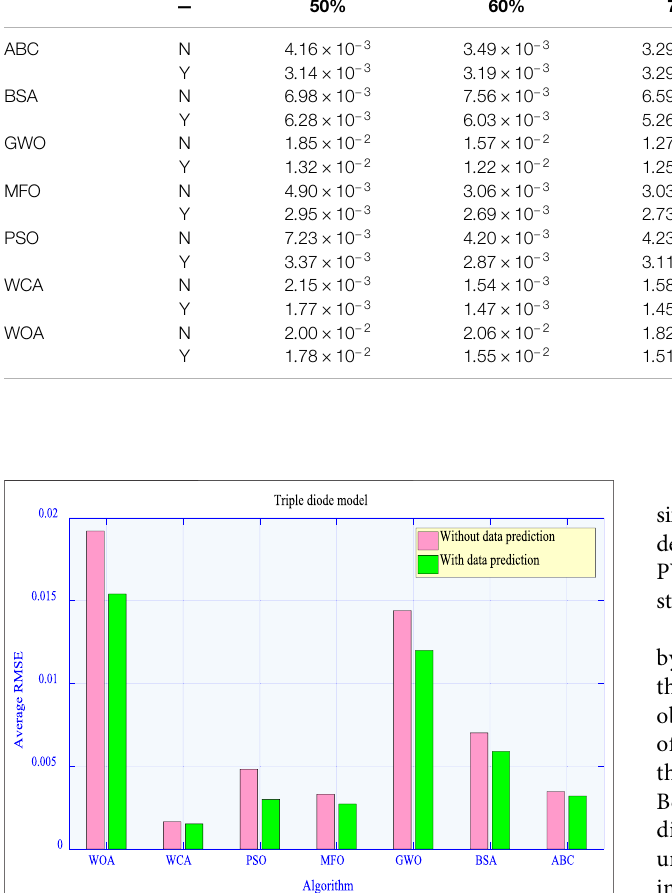
Number of measured data (%)